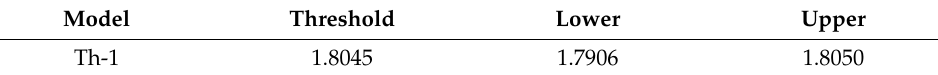
Table 4. Single-threshold estimator.